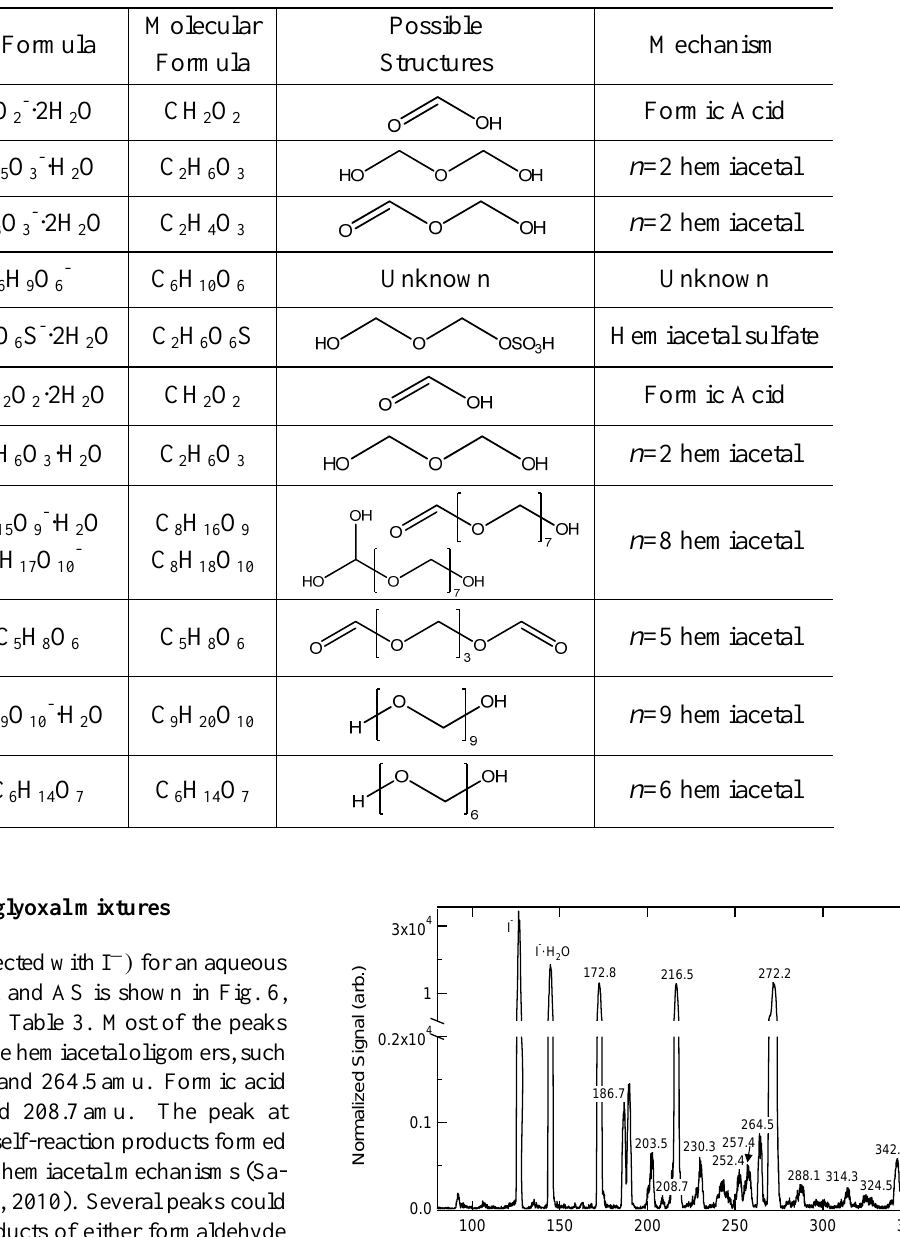
Table 2. Proposed peak assignments for Aerosol-CIMS mass spectra with I − of atomized solutions of 0.2 M formaldehyde in 3.1 M AS.